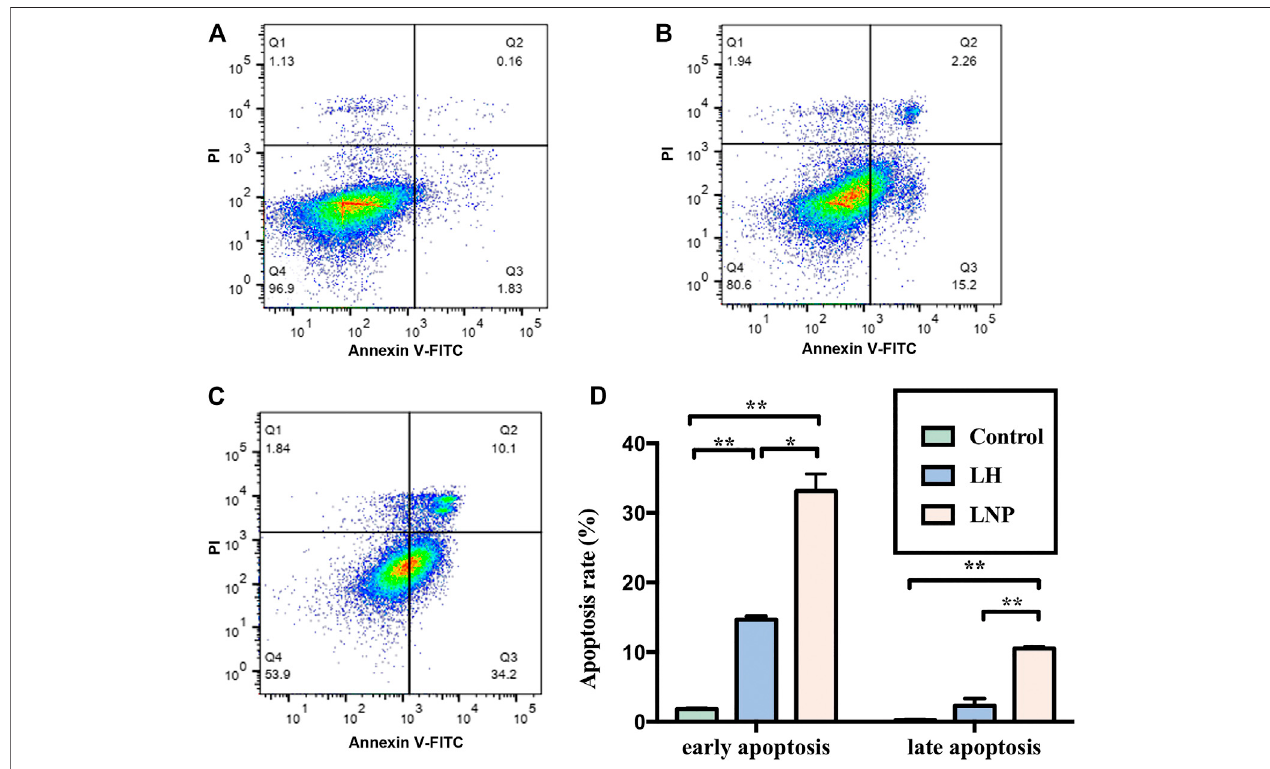
FIGURE 4 | Apoptosis of A375 cells induced by LNPs or LH. Representative fl ow images were shown for the control group (A) , LH group (B) , and LNP group (C) . Comparison of analyzed apoptosis rate between different groups was shown in (D) . * p < 0.05, ** p < 0.01 by one-way ANOVA with Tamhane ’ s T2 post-hoc test.